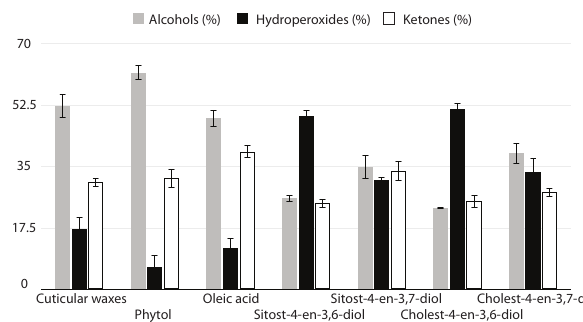
Figure 7. Relative percentages of intact hydroperoxides and their ketonic and alcoholic degradation products measured in the case of ω -hydroxyoleic (cuticular waxes) and oleic acids, phytol, sitosterol and cholesterol oxidation products. Standard error was calculated based on the results obtained for all